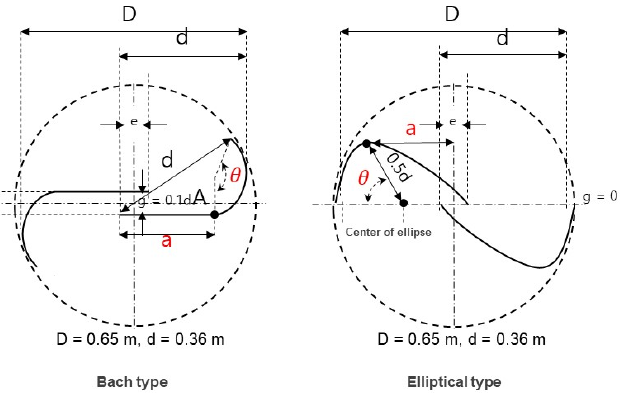
Figure 9. Definitions of design parameters for Bach and elliptical rotors.